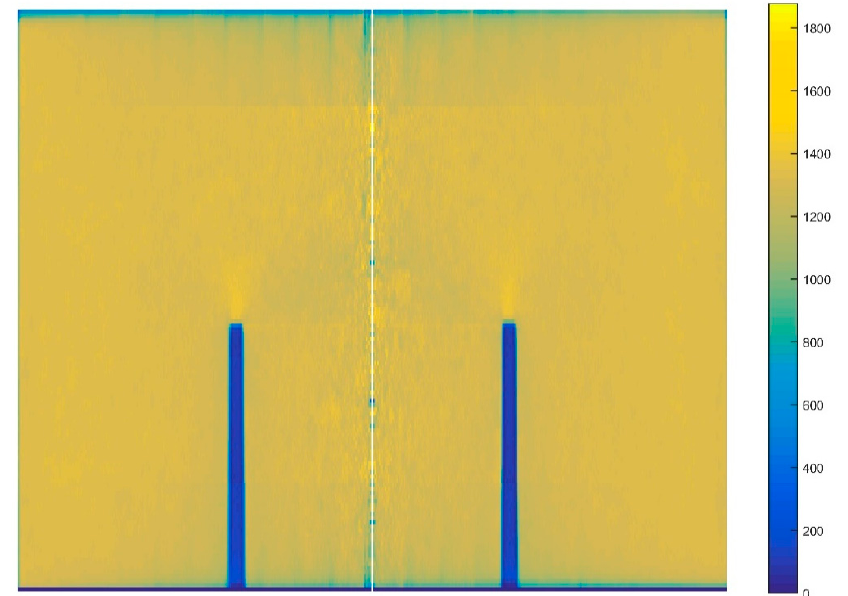
Figure 12. Mean distribution of the density along the radial axis for the sample with the circular slot.